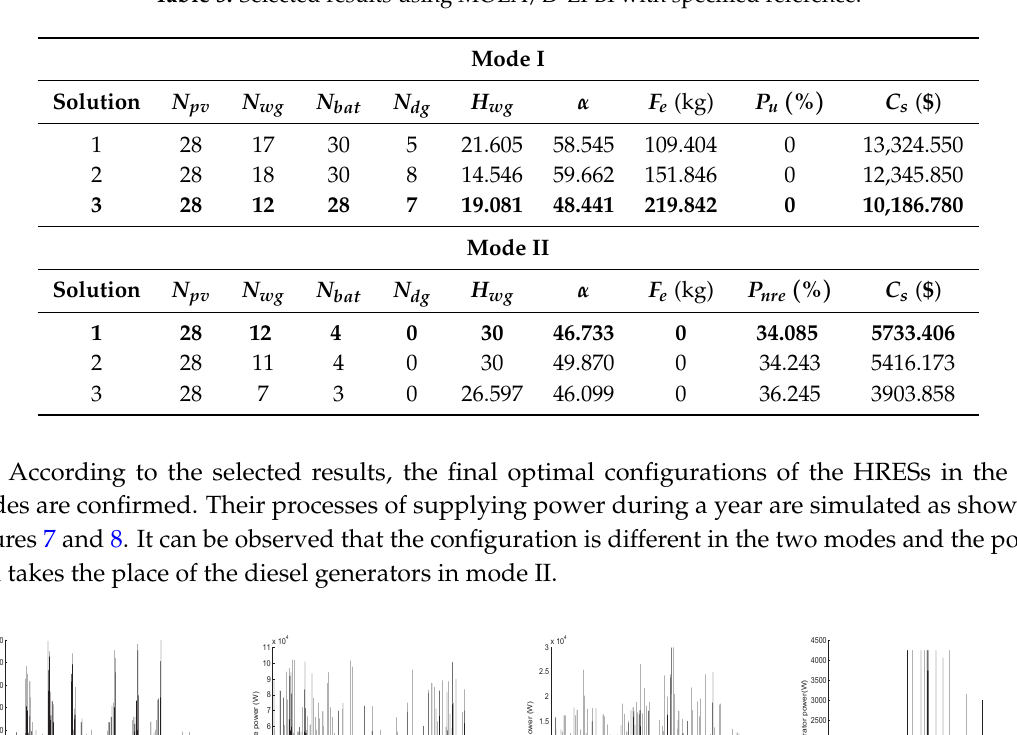
Table 5. Selected results using MOEA/D-LPBI with specified reference.